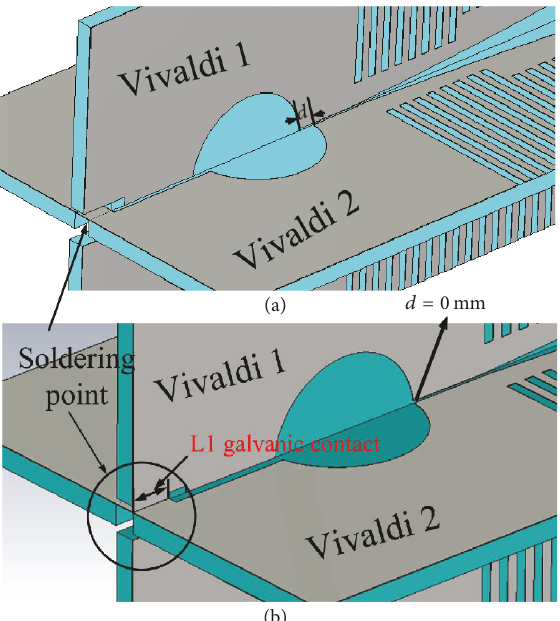
Figure 6: The structure of dual-polarized Vivaldi antenna: (a) conventional dual-polarized Vivaldi antenna; (b) modified dual-polarized Vivaldi